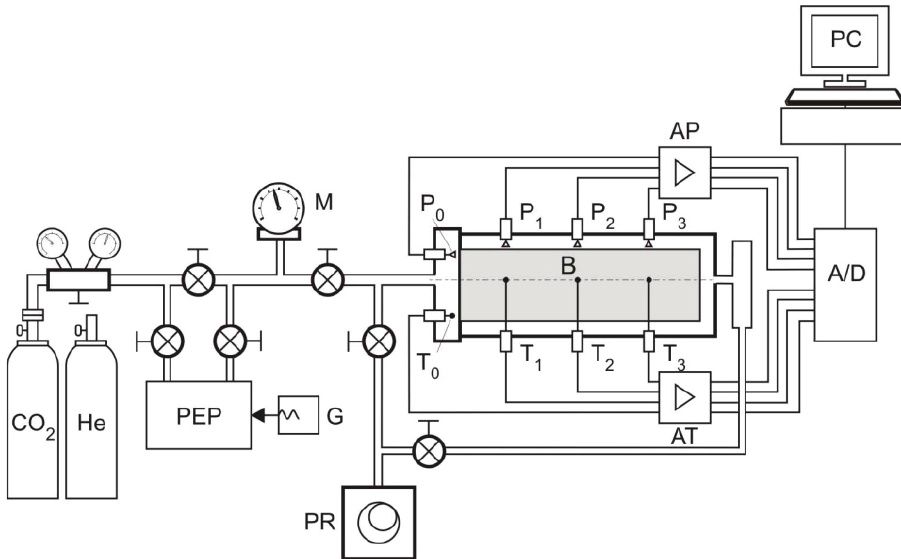
Figure 7: Scheme of the measurement station for determining the gas filtration coefficient in coal